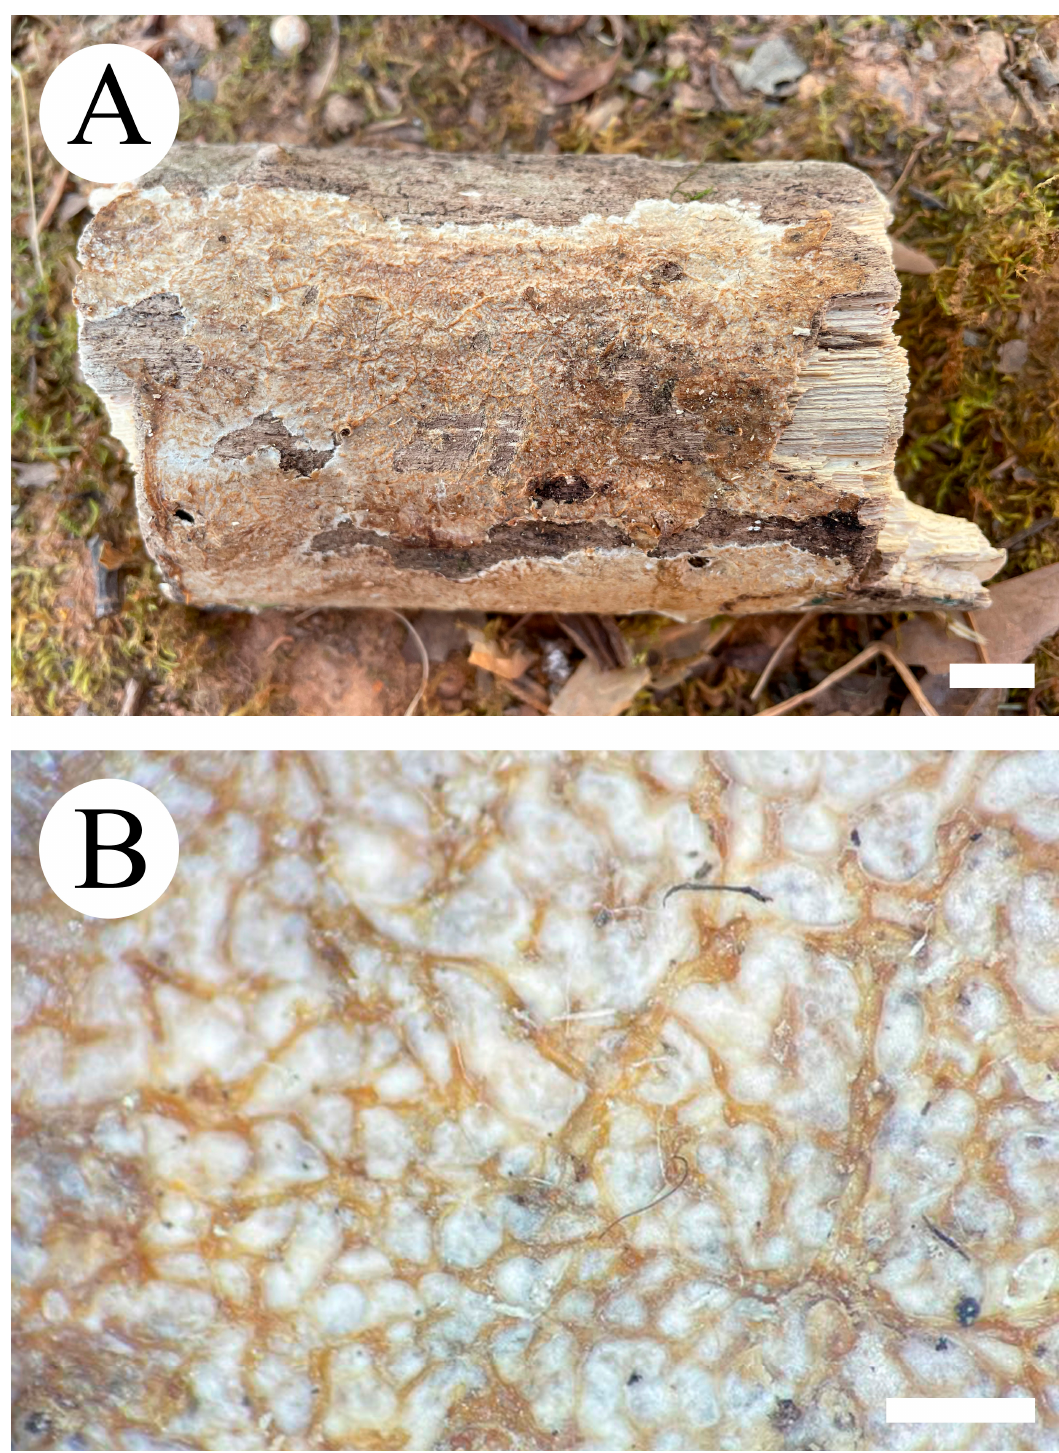
Figure 13. Basidioma of Phlebia niveomarginata (CLZhao 19089, holotype). Bars: ( A ) = 1 cm, ( B ) = 1 mm.